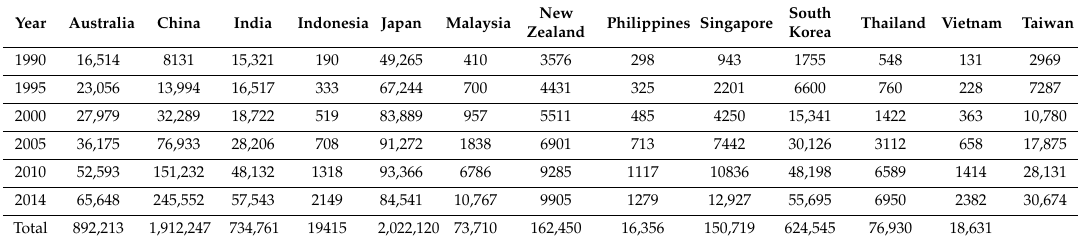
Table 2. Year-wise literature growth of selected